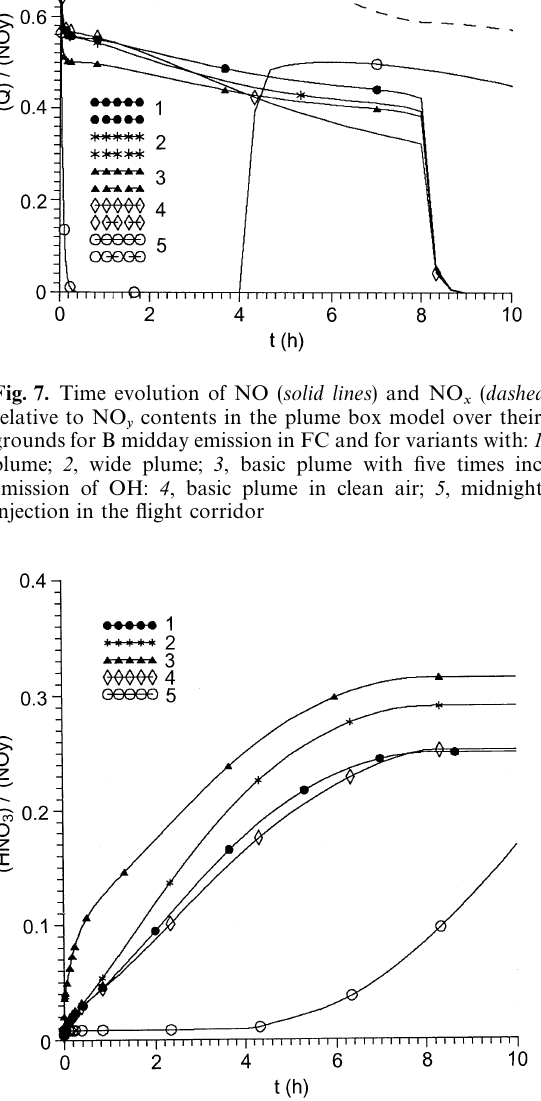
Fig. 8. Same as in Fig. 7 but for HNO (cid:51) evolution